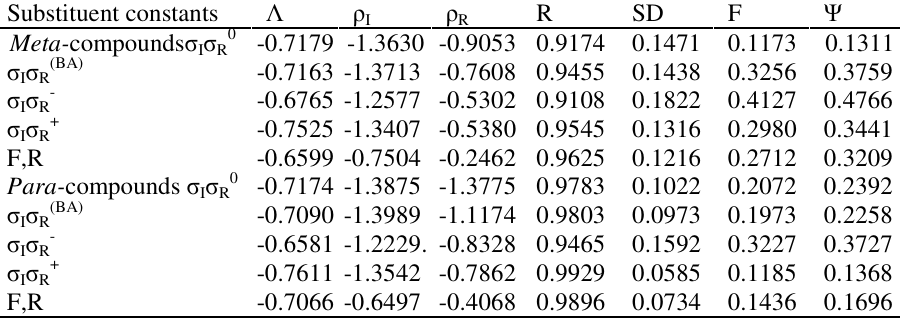
Table 3 Results of multiple regression analysis of the rate data of meta- and para- substituted Benzyl alcohols by PIA at 303K